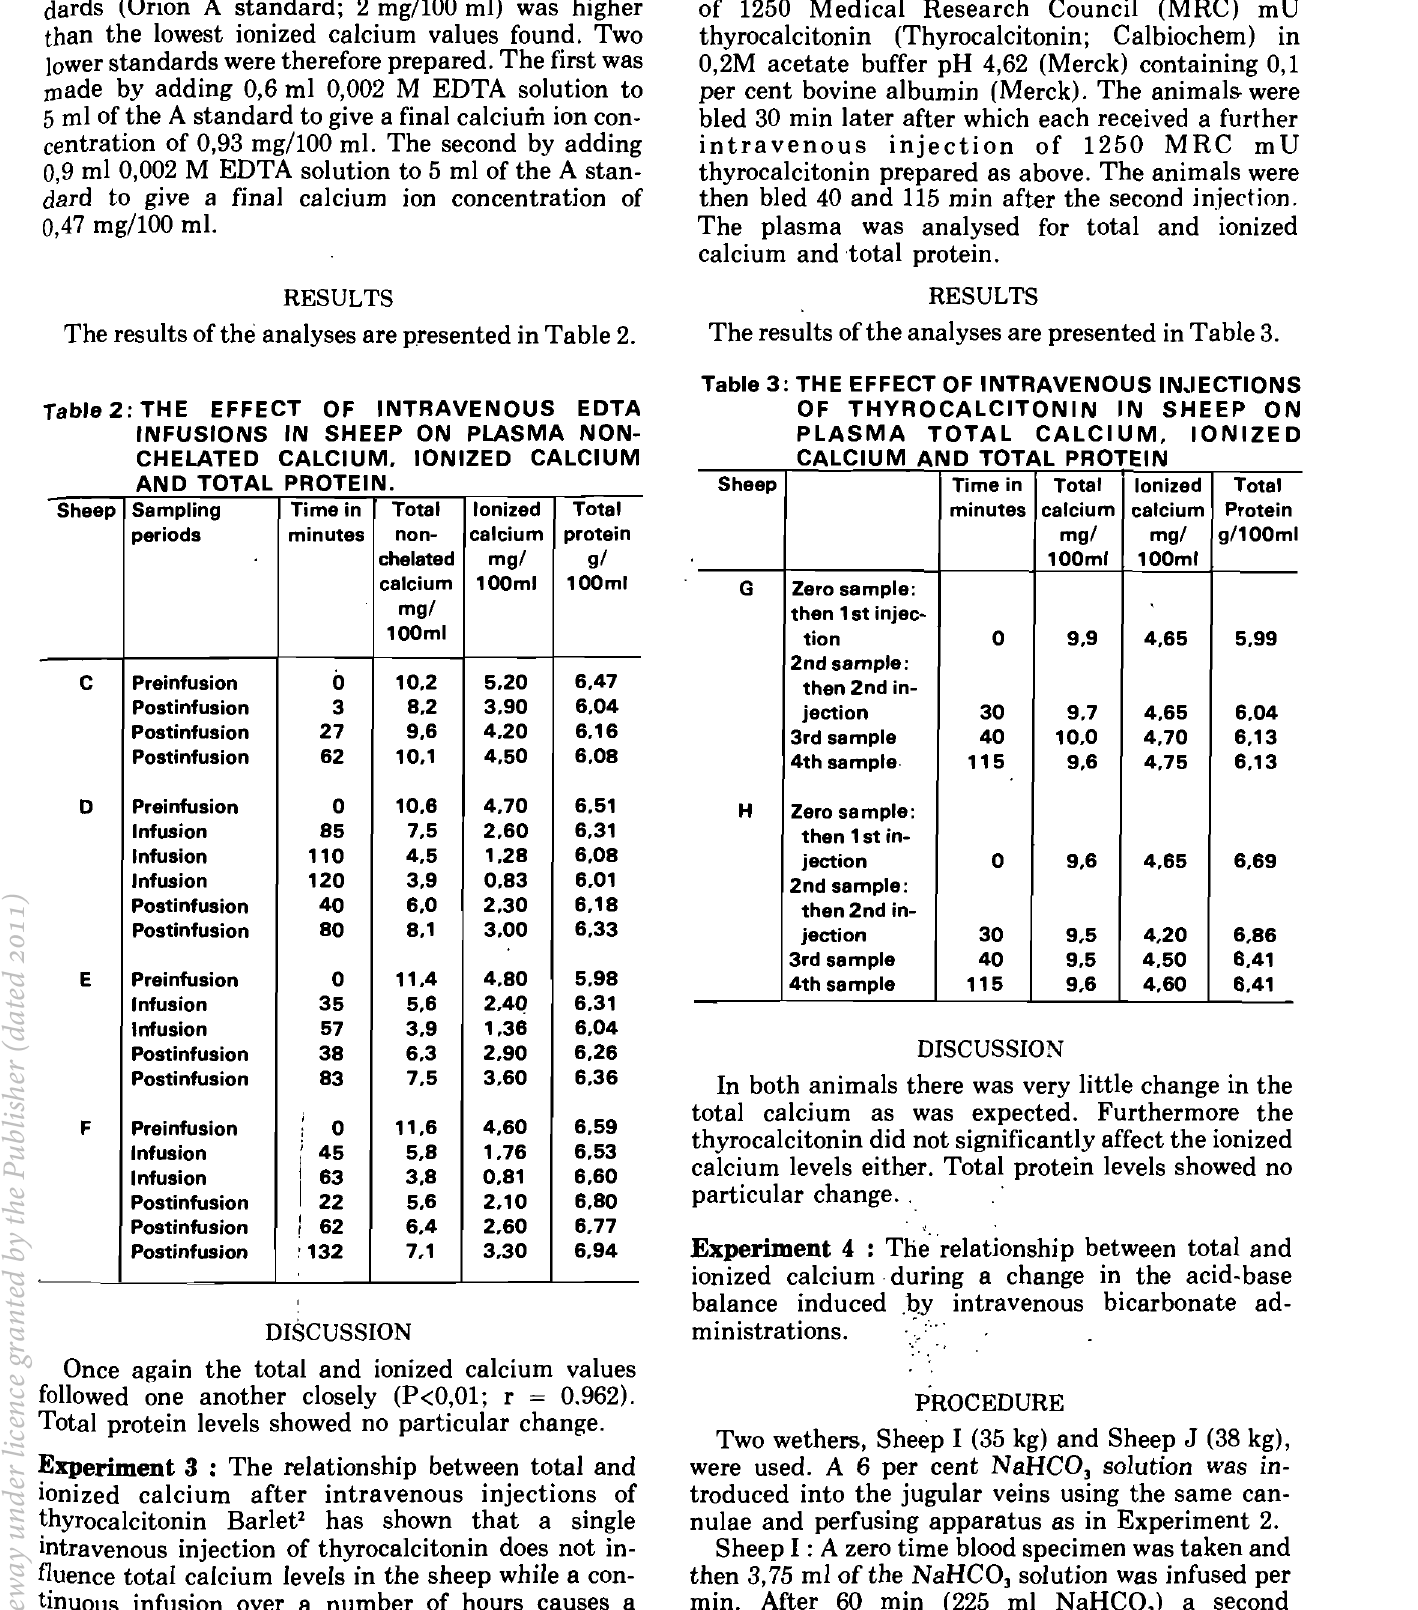
Table 2: THE EFFECT OF INTRAVENOUS EDTA INFUSIONS IN SHEEP ON PLASMA NON CHELATED CALCIUM. IONIZED CALCIUM AND TOTAL PROTEIN Sheep Sampling